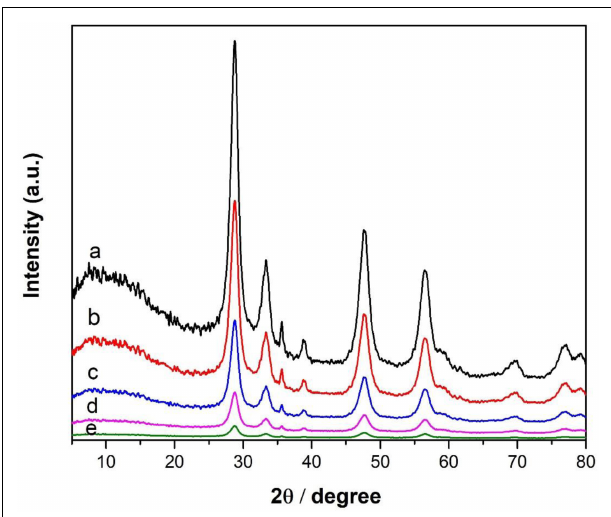
FIGURE 2 | XRD patterns of pristine MMO before and after PEI loading: (a) pristine MMO; (b) MMO-PEI-30; (c) MMO-PEI-40; (d) MMO-PEI-50; (e) MMO-PEI-60.